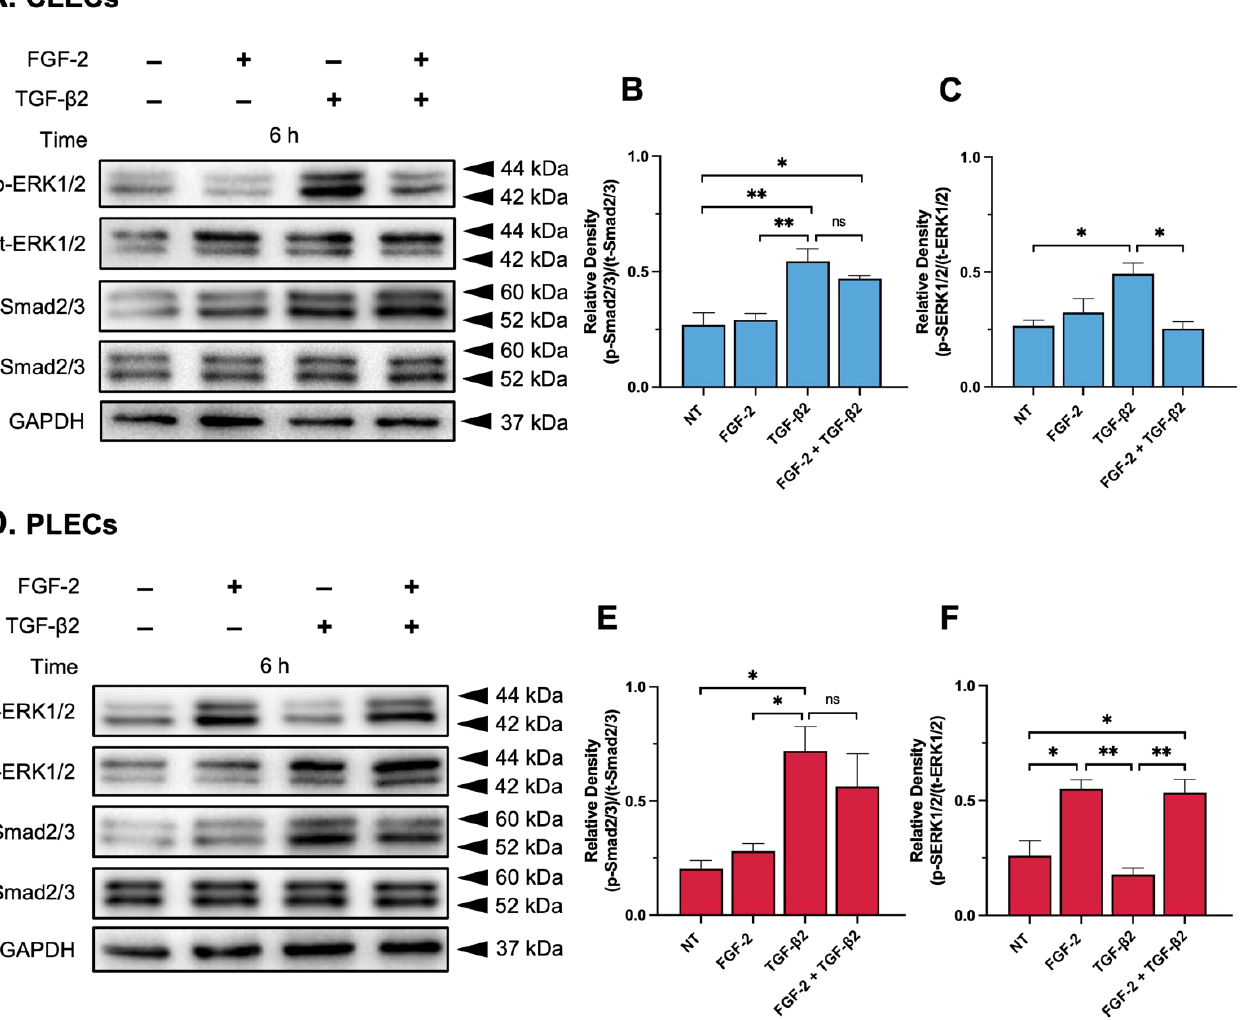
Figure 6. FGF-2 modulates TGF- β2 -signalling. Representative Western blots demonstrating protein levels of phosphorylated and total Smads (p-Smad2/3 and t-Smad2/3) and MAPK/ERK1/2 (p- ERK1/2 and t-ERK1/2) in the control (non-treated, NT), FGF-2, TGF- β2, and FGF -2/TGF- β2 cot reated CLECs ( A – C ) and PLECs ( D – F ). The protein densitometry analysis shows changes in the levels of relative phosphorylation of Smad2/3 ( B , E ) and ERK1/2 ( C , F ). One-way ANOVA with the mean ± SEM and post- hoc Tukey’s multiple comparisons test (ns = not si gnificant, * p < 0.0332, ** p < 0.0021).